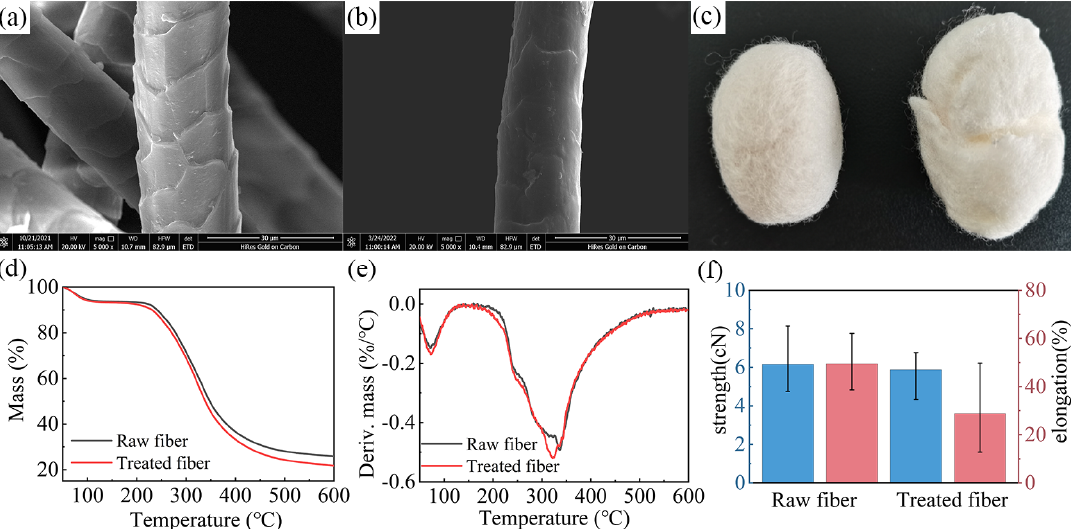
Figure 4. SEM images of ( a ) raw wool and ( b ) treated fibers. ( c ) Felted ball method test results. ( d ) TG, ( e ) DTG, and ( f ) tensile strength results of the fiber samples.